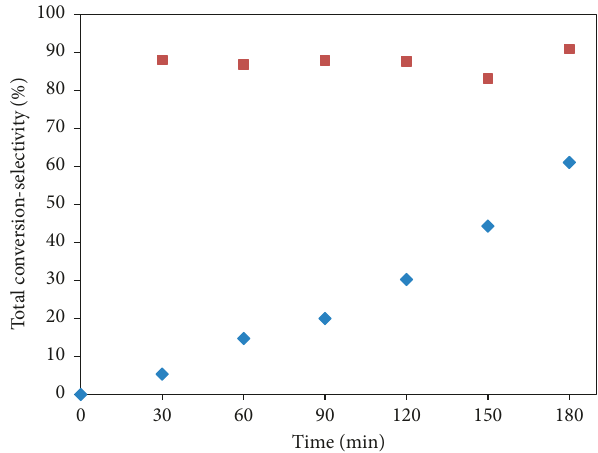
Figure 9: Total conversion ( ) and selectivity to 1-heptene ( ) versus time (min) for the Lindlar catalyst (reproduced from Lederhos et al. [52], under the Creative Commons Attribution License/public domain).